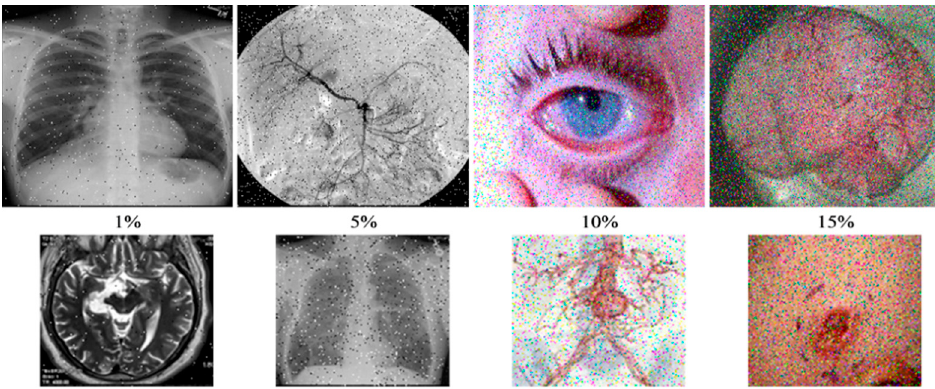
Figure 7. Stego and extracted images under noise of various densities. The first row shows the stego images with added Salt and Pepper noise and their corresponding extracted versions in the second row.